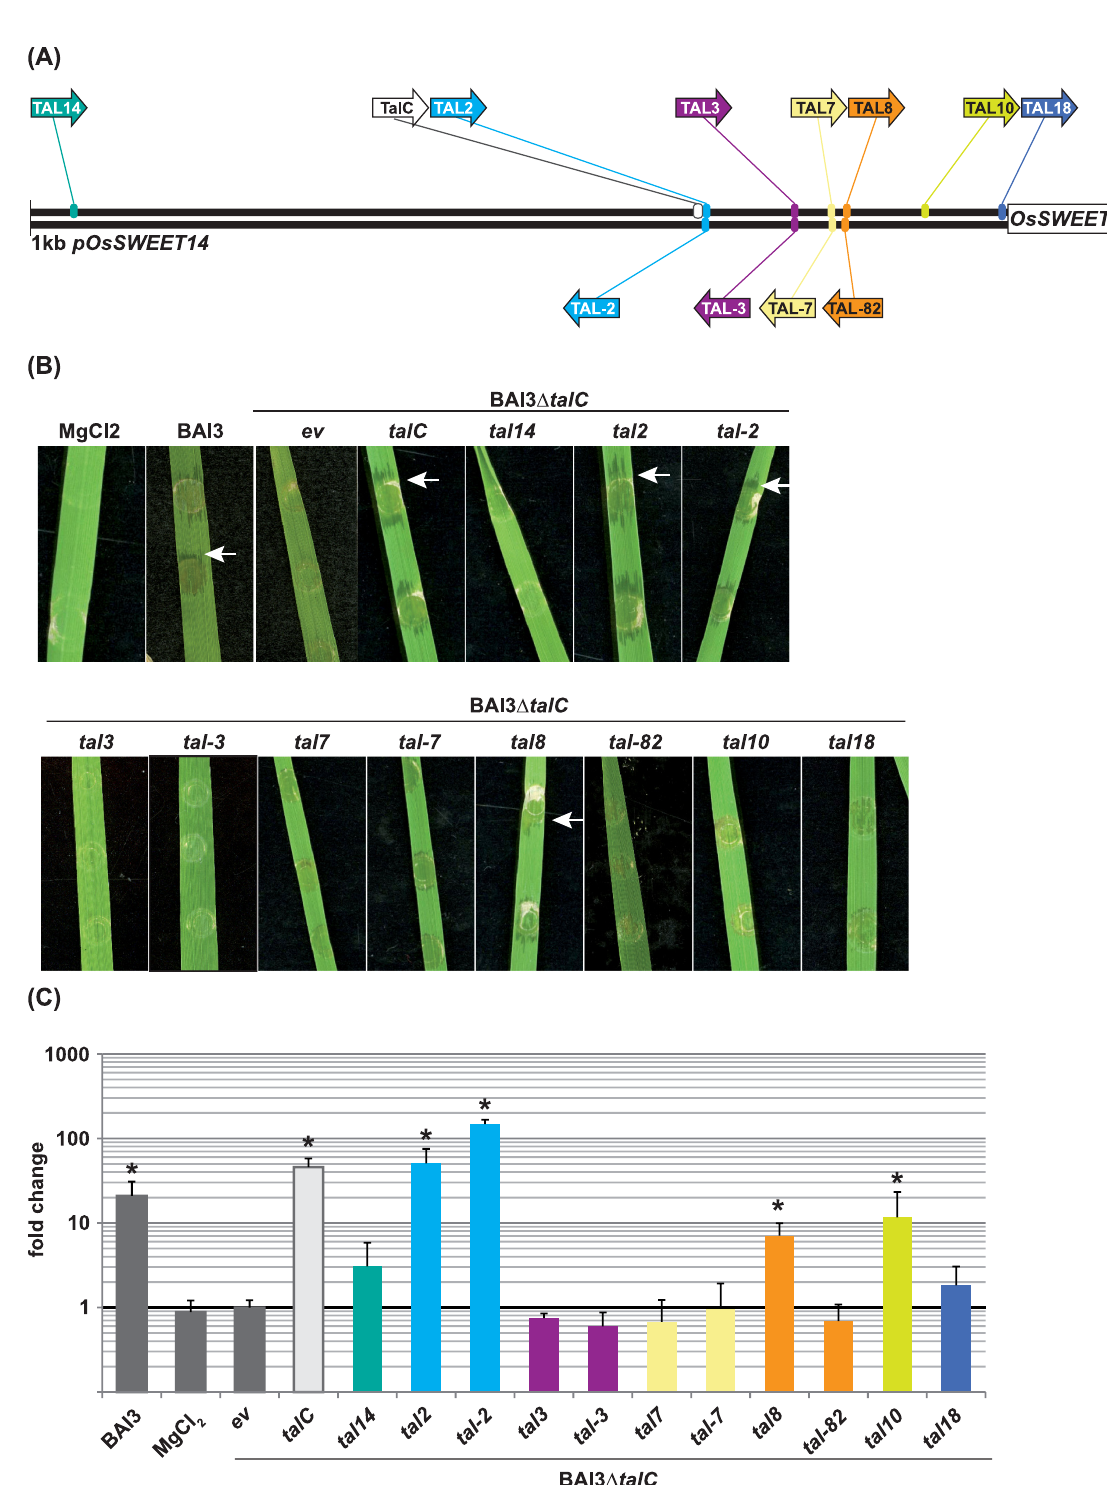
Fig 7. Reversebinding artificial TALEs can activate OsSWEET14 expression in a natural Xoo -rice infection. ( A ) Overview of the bindingsites and bindingorientationof analyzedartificial TALEs (colouredarrows) and of the natural TALE TalC (white arrow). ( B ) Reverse- and forward-orientedTALEs can both support diseasedevelopment of Xoo in rice. Leaves of Oryza sativa cv. Nipponbarewere inoculatedwith the Xoo strains BAI3, BAI3 Δ talC or BAI3 Δ talC carryingan empty vector plasmid( ev ), talC or an artificial TALE on a plasmid. Inoculation of rice leaves with MgCl 2 served as negativecontrol. Pictures of phenotypes were taken 5